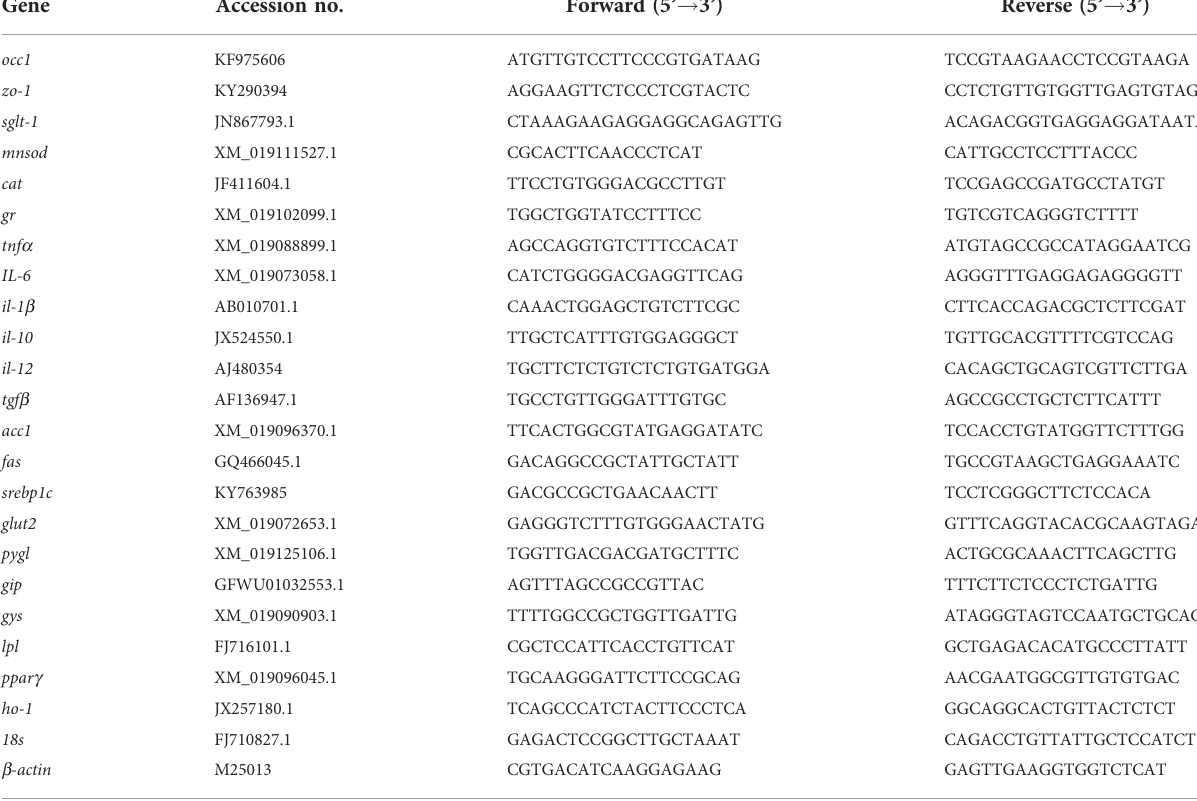
TABLE 2 Primers used in this